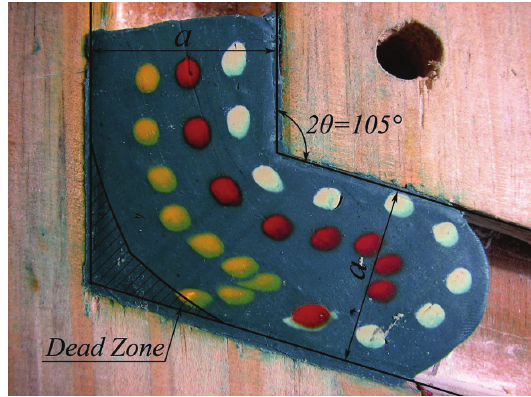
Figure 10. The physical simulation-derived geometry of observable dead zone during ECAE of plasticine workpiece model through the die with 2 θ =105° , where S/a 2 =